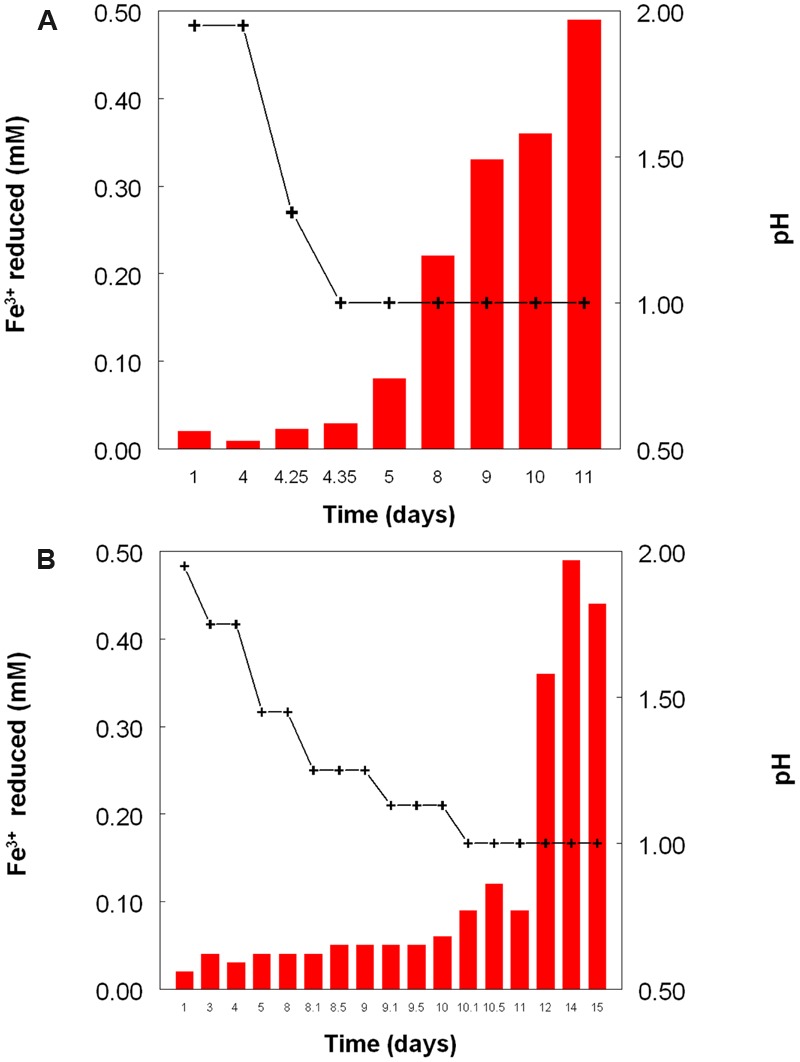
Reduction of iron (III) (red bars) by samples of cultures of (A)
At. caldusT, and (B)
At. ferriduransT grown in bioreactors at varying pH. Stepwise decreases in bioreactor pH are depicted by the black line.